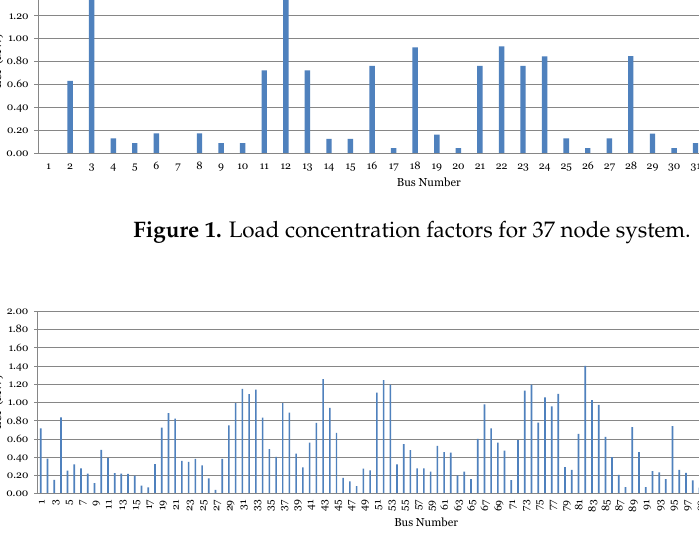
Figure 2. Load concentration factor for 119 node